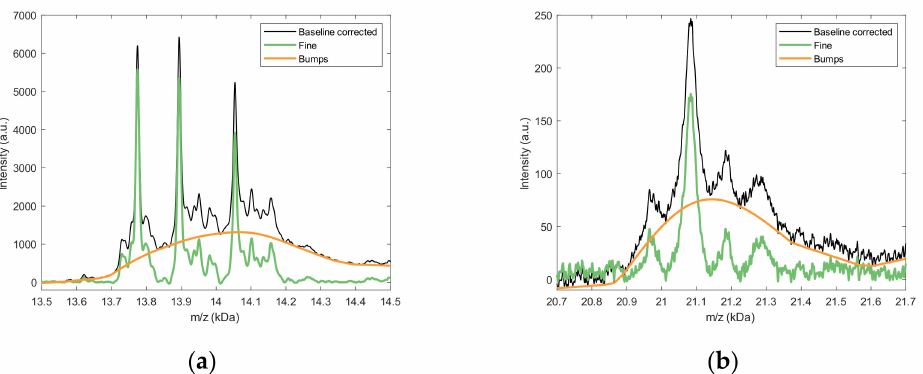
Figure 2. Spectral component analysis showing the baseline corrected Deep MALDI spectrum (black), fine structure (green), and bumps (orange) for peak clusters around ( a ) 14 kDa and ( b ) 21